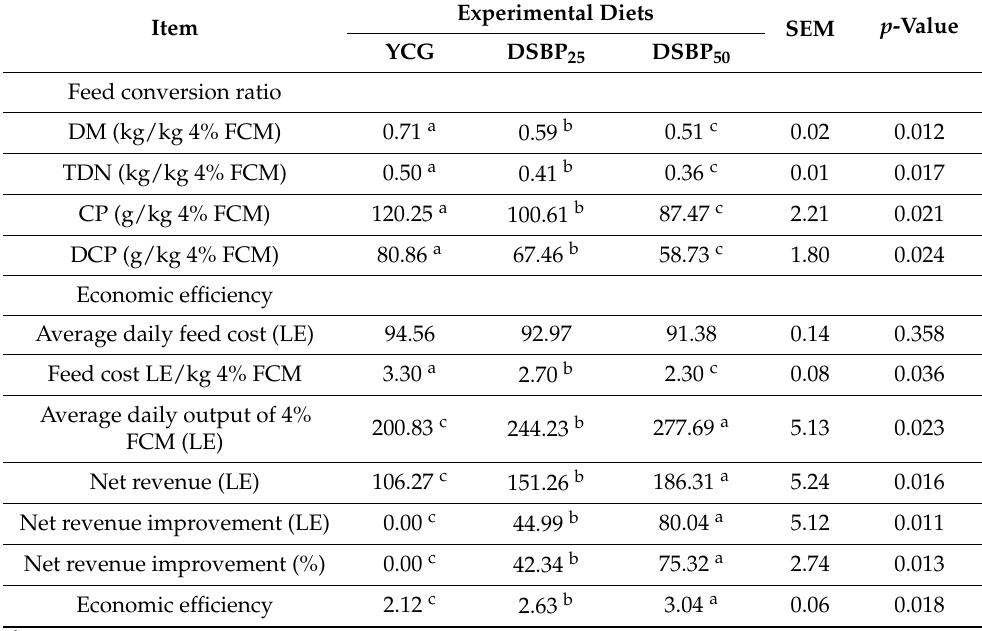
Table 9. Feed efficiency for cows fed different